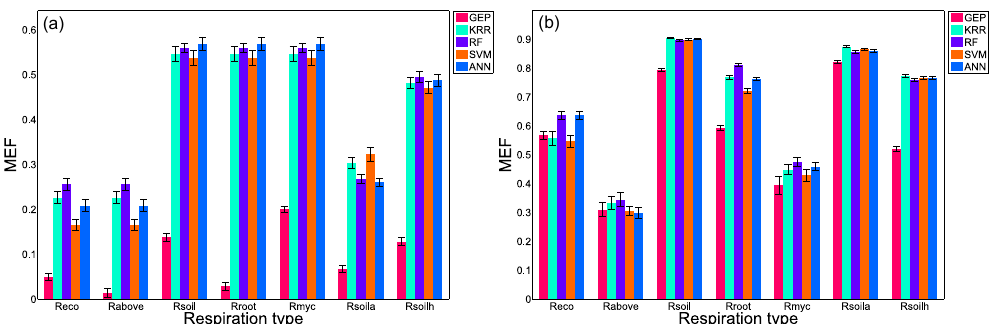
Figure 13. Machine learning methods (MLM) prediction performance for all respirations components (a) and for the residuals (b) resulting from the GEP trained models after smear term bias corrected back-transformation. The MEF values obtained for validation by all the MLM methods for R eco , R above , R soil , R root , R myc , R soil , R soil a h